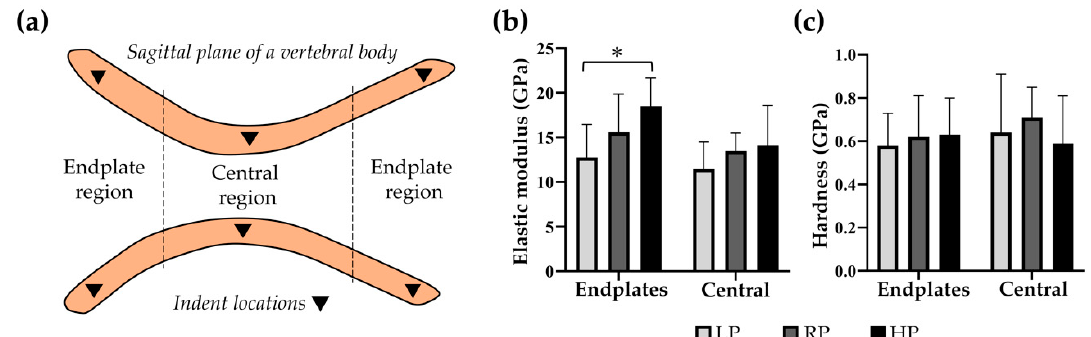
Figure 4. High dietary P is associated with higher stiffness in the bone formed after two months of treatment. ( a ) Schematic representation of nanoindentation measurements in the sagittal plane of a vertebral body. ( b ) In the endplates, the elastic modulus as indicator for stiffness shows significantly higher values in HP compared to LP (*: p = 0.004), and a trend towards higher values in HP compared to RP ( p = 0.073). In the central region, all dietary groups showed similar values. ( c ) The hardness of the vertebrae was similar in all dietary groups in both the endplates and central regions.